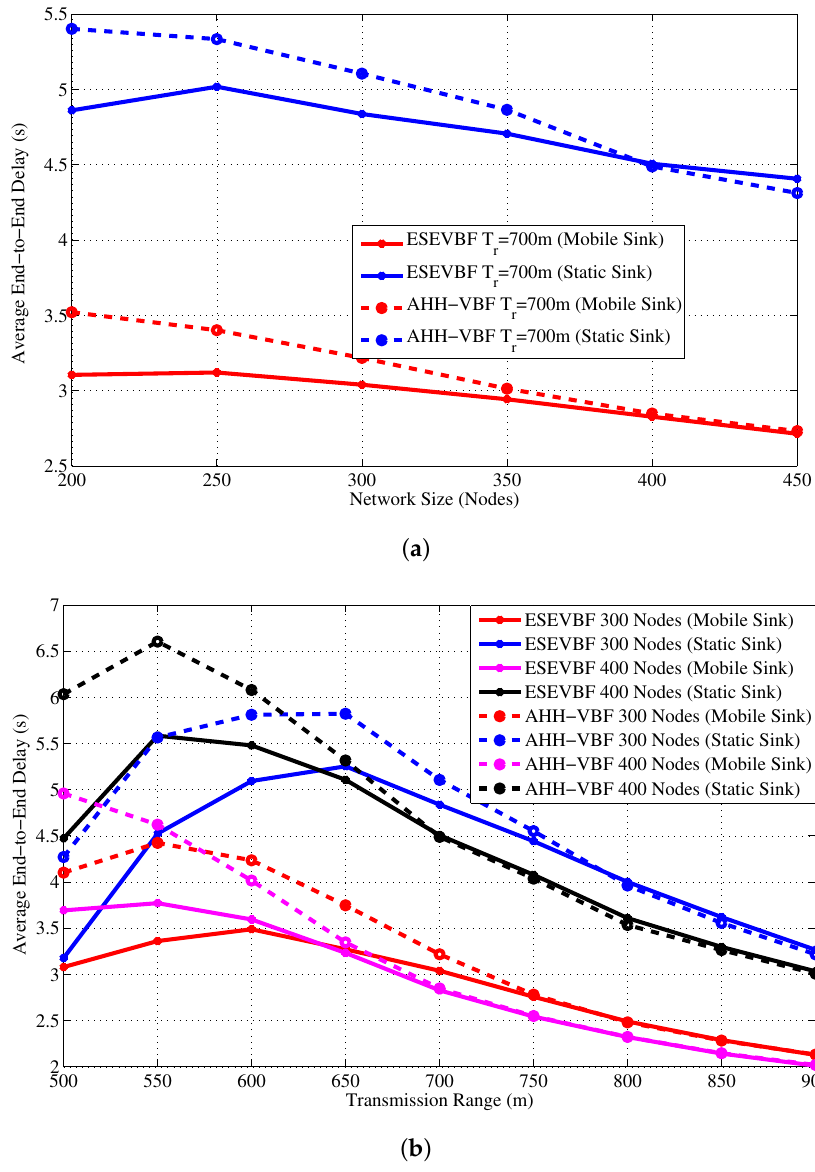
Figure 21. End-to-end delay experienced by the data message in a network with static and mobile Sink for varying ( a ) network size ( b ) transmission